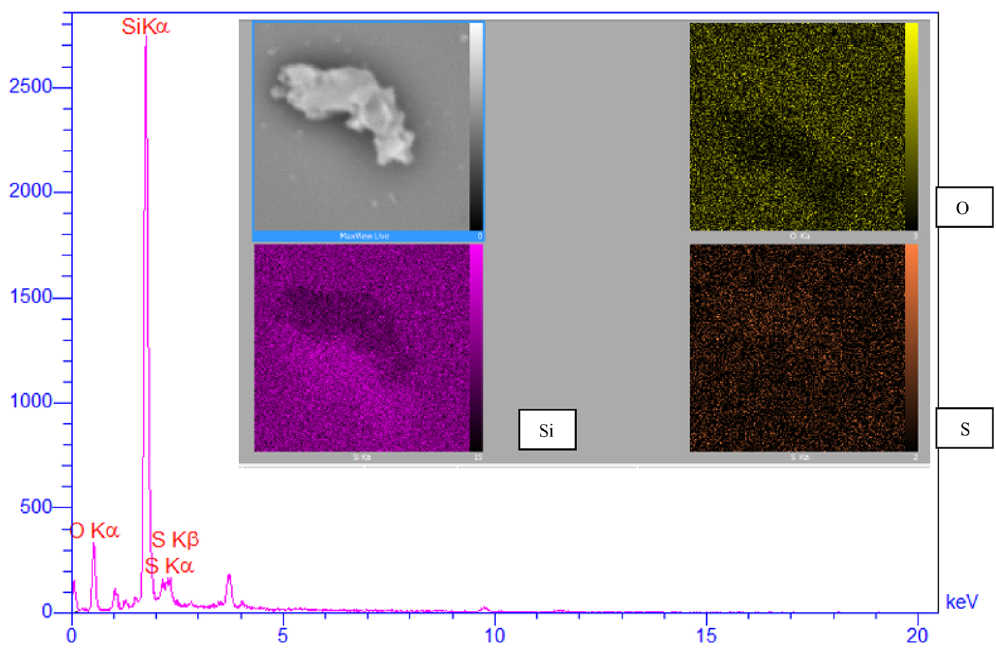
Figure 4. The EDX analysis of the fresh MCM-41-SO 3